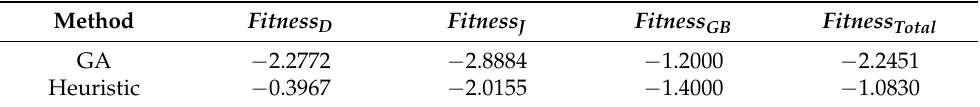
Table 3. Heuristic and GA-based scheduling